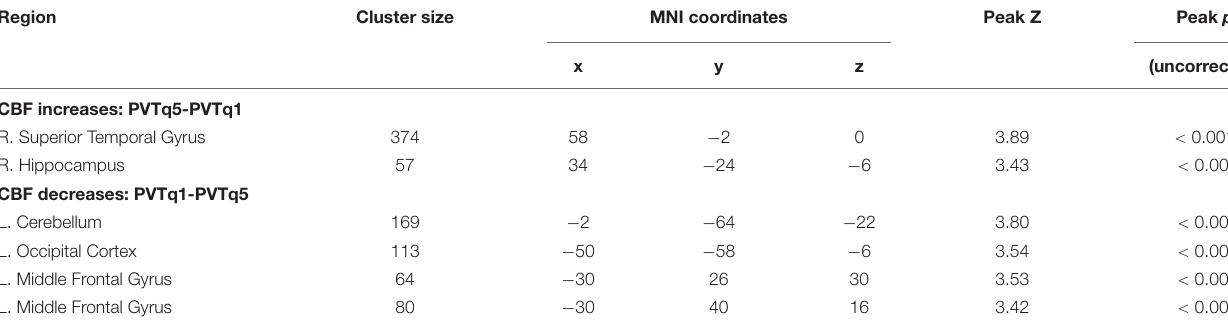
TABLE 2 | Brain areas showing CBF changes for the last quintile of the PVT comparing to the first quintile of the PVT (PVTq5 vs. PVTq1). Region Cluster size MNI coordinates Peak Z